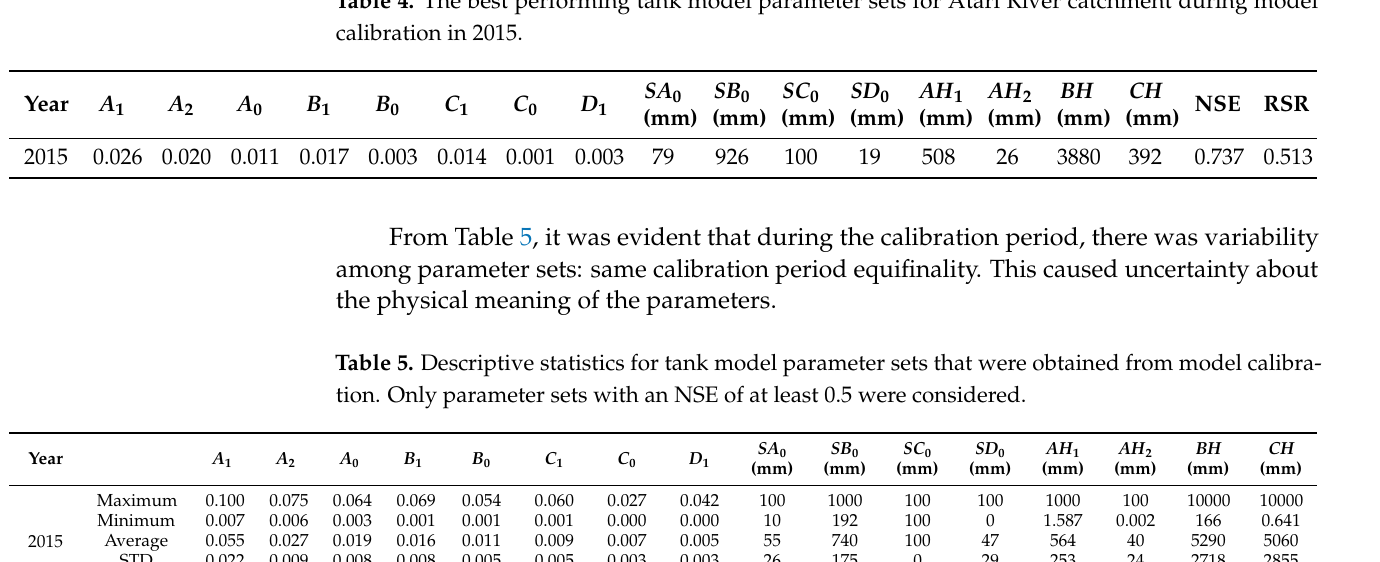
Table 4. The best performing tank model parameter sets for Atari River catchment during model calibration in 2015.